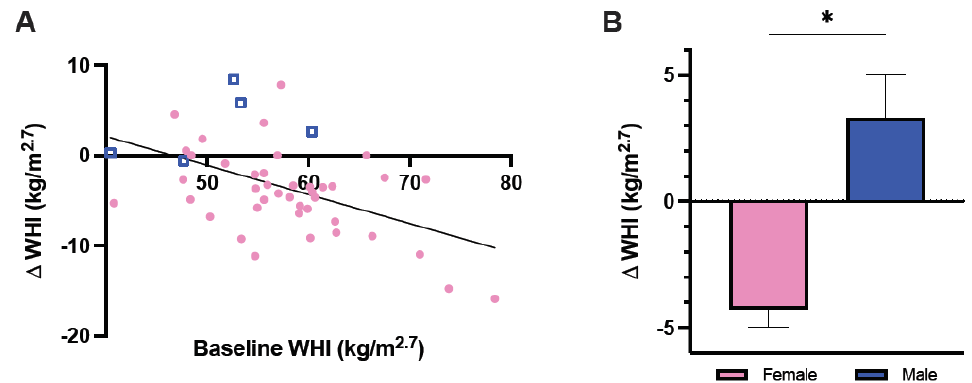
Figure 1. Effect of baseline weight-for-height index (WHI) ( A ) and sex ( B ) on delta WHI in full-grown adult male and female long-tailed macaques. Note that the y-axes are not equally scaled. Circles represent females; squares represent males. Error bars represent the standard error. * p < 0.05.